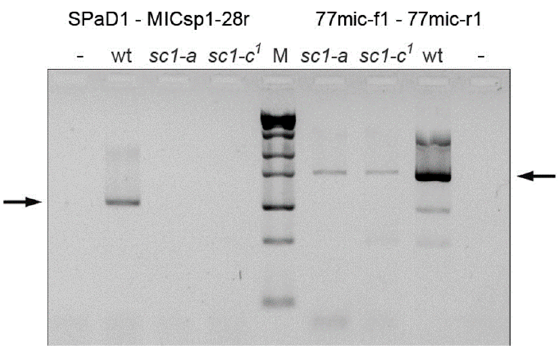
Figure 5. The MIC deletions in screwy mutants sc1-a and sc1-c 1 confirmed by MIC-specific PCRs. Arrows show the expected PCR products. Control PCR of the region upstream to the deletion yielded the product for both mutants, while PCR product from the region deleted in MAC (left to the marker) is missing in both mutants, thus they lack this region also in their MICs. wt is wild-type strain; “–“ stands for negative control; M is ZipRuler™ Express DNA Ladder Set (Thermo Fisher, USA). For primers used in PCRs see Figure 2 (mapping) and Table S1 (sequences).